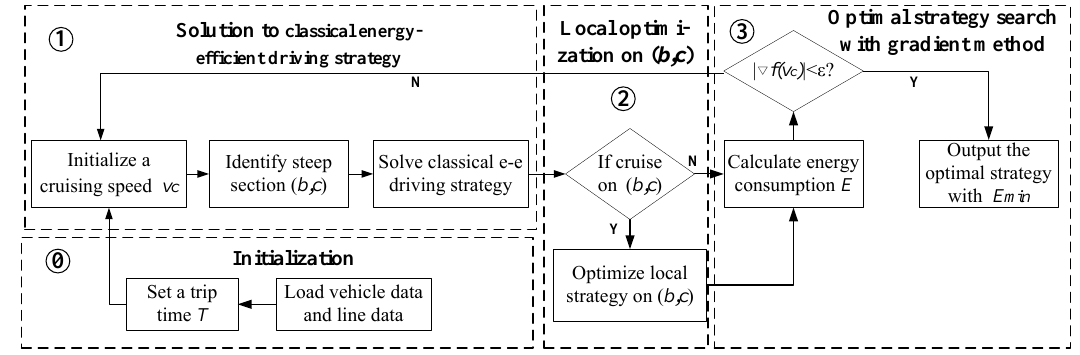
Figure 3. The structure of the proposed optimization